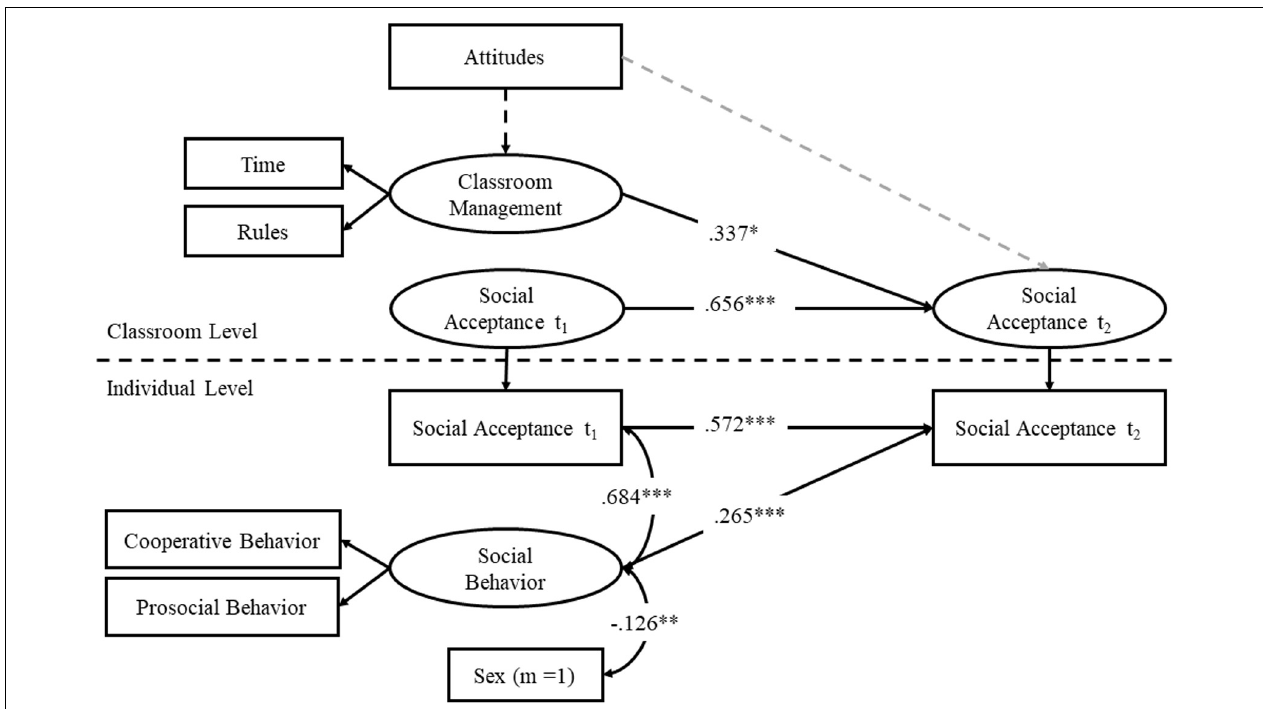
FIGURE 2 | Path diagram of the final model, containing all hypothesized paths and covariances. The dashed black arrow represents the hypothesized significant path between attitudes and classroom management that was not confirmed. The dashed gray arrow depicts the path between attitudes and social acceptance at t 2 that was hypothesized to be 0. Standardized estimates are provided with their respective level of significance (two-tailed). ∗ p < 0.05. ∗∗ p < 0.01. ∗ ∗ ∗ p <